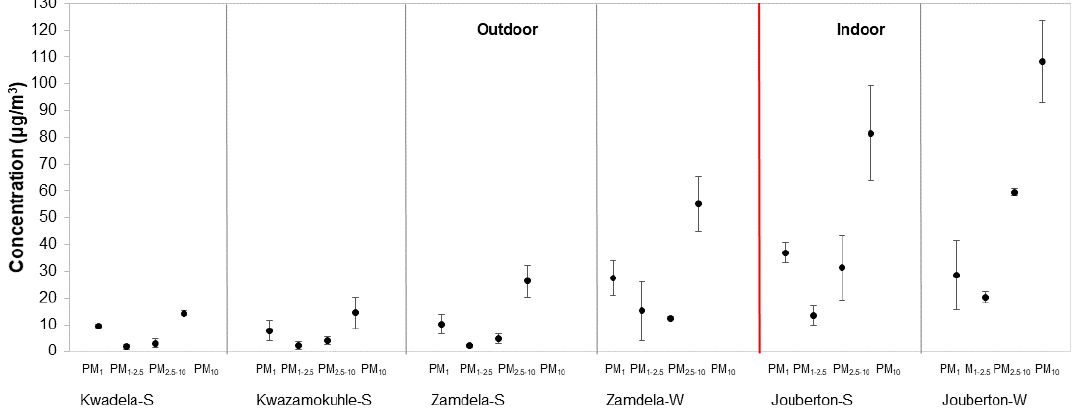
Figure 2. Mean aerosol mass concentrations ( ± SD) measured in PM 1 , PM 1 − 2 . 5 and PM 2 . 5 − 10 at each site (S denotes a summer campaign and W designates a winter campaign). Average PM 10 mass concentrations are also